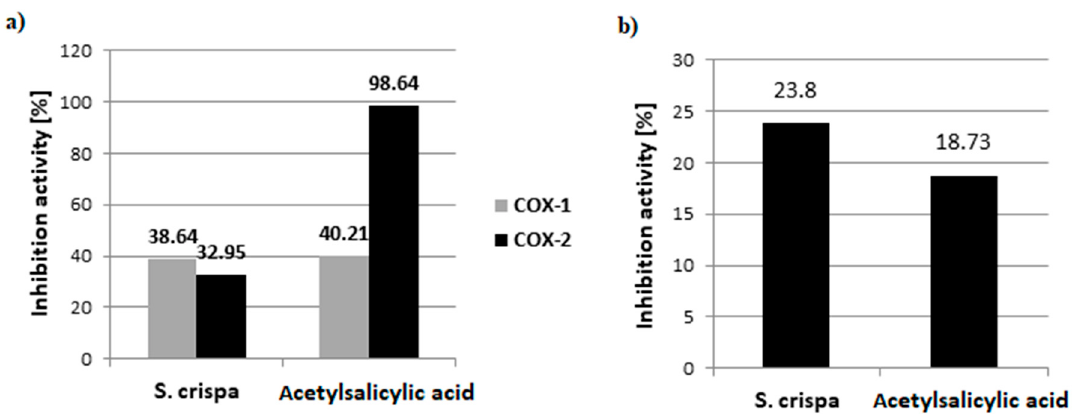
Figure 4. Inhibition of: ( a ) cyclooxygenase-1, cyclooxygenase-2 and ( b ) lipooxygenase activity by crude polysaccharides from S. crispa (5 mg/mL) expressed in %. Acetylsalicylic acid (1 mM) was used as a control.